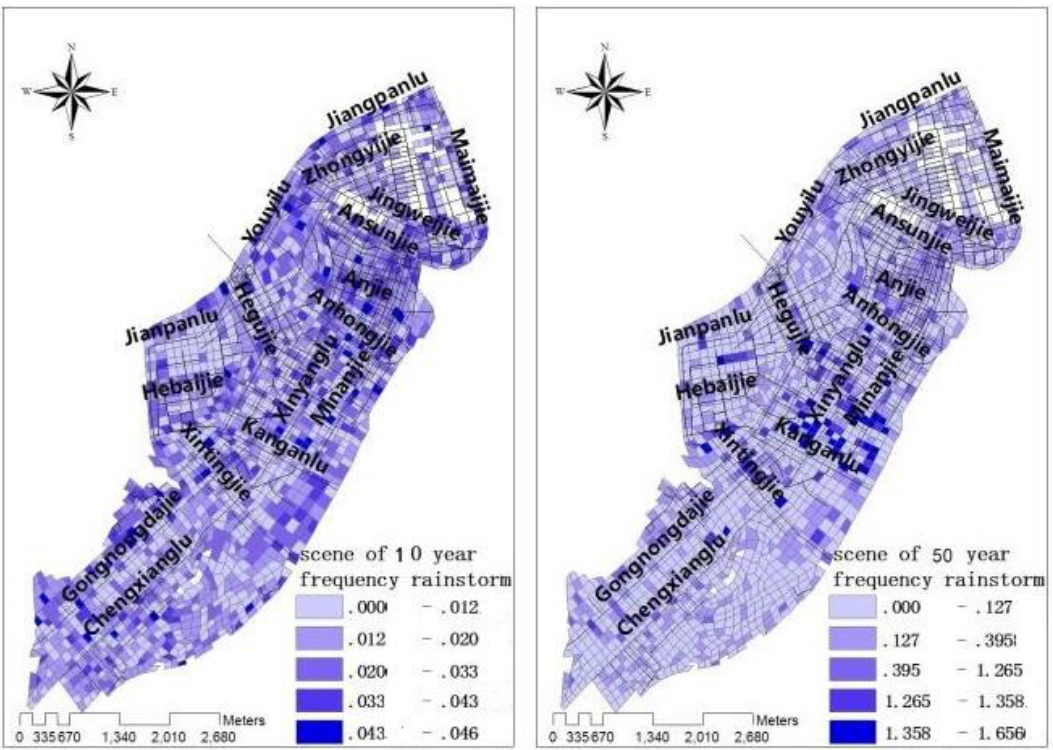
Figure 2. Road waterlogging status under 10-year frequency rainstorm and 50-year frequency rainstorm conditions [1].